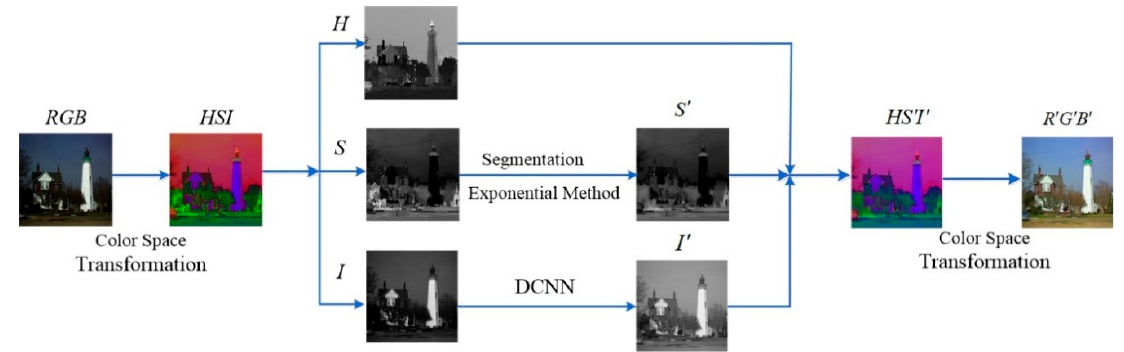
Figure 4. The flow of our method.